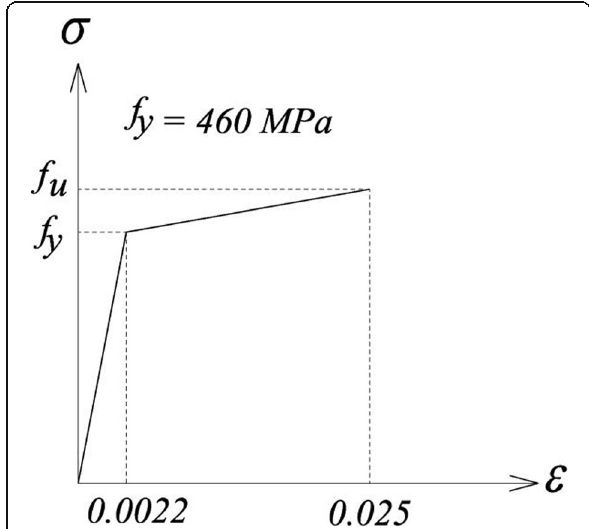
Fig. 7 Constitutive model for steel reinforcement (reference